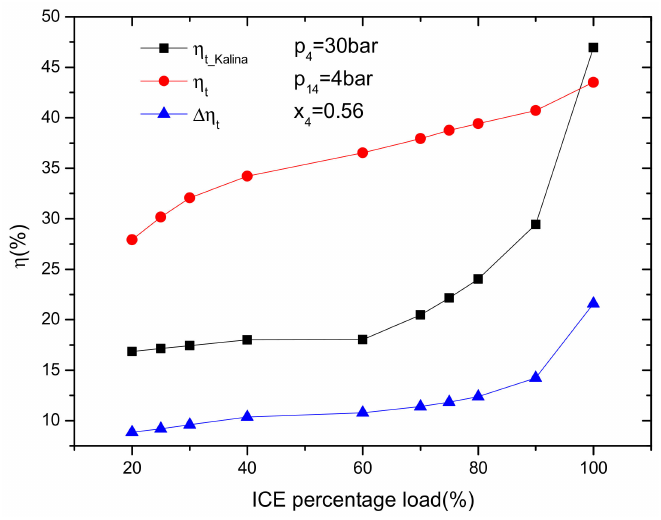
Figure 5. Effects of ICE percentage load on η t_Kalina , η t and ∆ η t .